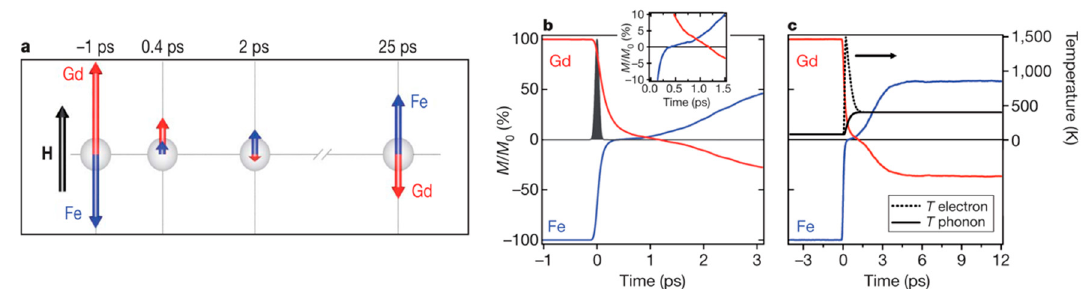
Figure 14. Computed time-resolved dynamics of the Fe and Gd magnetic moments from the localized atomistic spin model. ( a ) Cartoon-like illustration of the non-equilibrium dynamics of the Fe and Gd magnetizations with respect to an external magnetic field H. Simulated dynamics for the first 3 ps ( b ) and the first 12 ps ( c ) after laser excitation. As can be clearly seen, the demagnetization of the Fe is much faster than that of the Gd (see inset in b; axes same as main panel). For a time of 0.5 ps, we observe a parallel alignment of the magnetizations of the sublattices. The agreement with the experimental data is qualitatively excellent. Reprinted with permission from ref. [53]. 2011 Springer Nature.